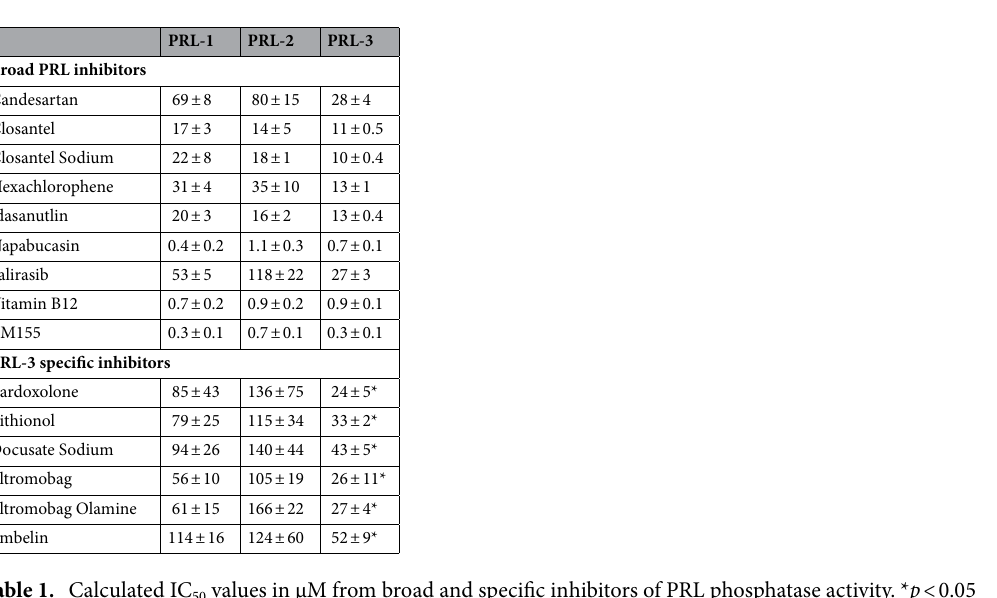
Table 1. Calculated IC 50 values in μM from broad and specific inhibitors of PRL phosphatase activity. * p < 0.05 between IC50 values for PRL-3 and PRL-1 and PRL-2 by one-way ANOVA with Tukey’s HSD.